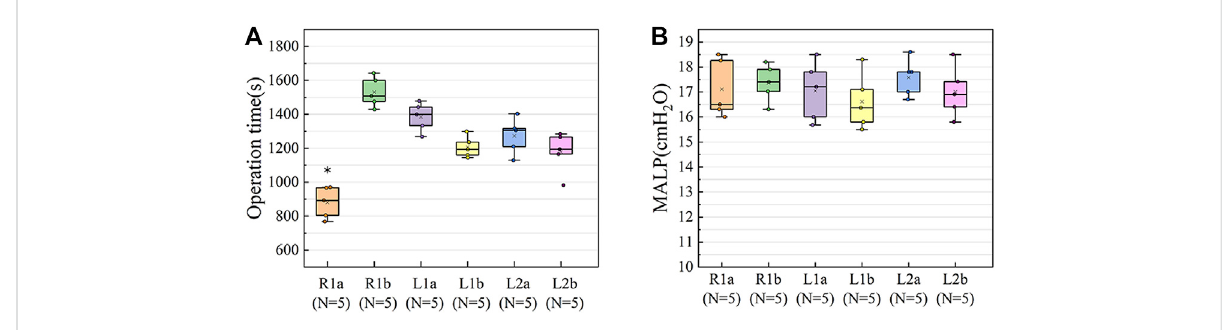
FIGURE 5 Resultsofthepre-experiments. (A) TheoperationtimeofR1awasshorterthanintheothergroups(F=27.26, p < 0.05). (B) Thedifferenceinthe MALP between the six groups of models was not statistically signi fi cant (F = 0.519, p = 0.76). The upper and lower borders of the box represent, the upper and lower quartiles. The middle horizontal line represents the median. The cross represents the mean. The whiskers show the minimum and maximum values excluding the outliers. * p < 0.05, the operation time of R1a versus the other lung segments. R1a, R1b (a and b segments of the rightcraniallobe); L1a, L1b(aand bsegments oftheleftcraniallobe); L2a,L2b(a and bsegments oftheleftcaudal lobe);MALP (minimum air leakage pressure).